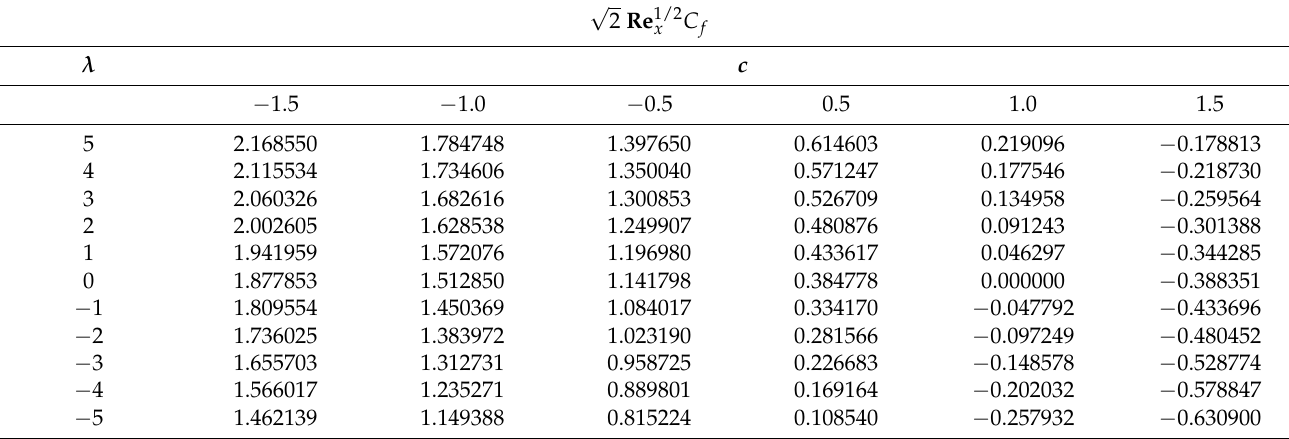
The profiles of velocity f (cid:48) ( η ) and temperature θ ( η ) in Figures 7 and 8, respectively, Table 5. √2 Re 𝑥−1/2 𝑁𝑢 𝑥 values for various values of c. highlight the influence of nanoparticle volume fraction φ 2 (for CoFe 2 O 4 ) in √𝟐 𝐑𝐞 𝒙−𝟏/𝟐 𝑵𝒖 𝒙